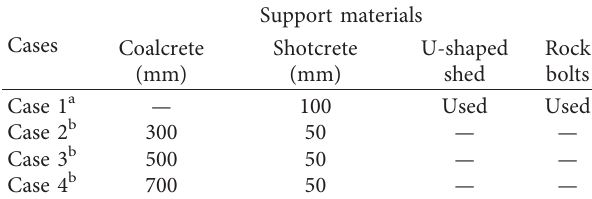
Table 6: Comparison of various support cases.